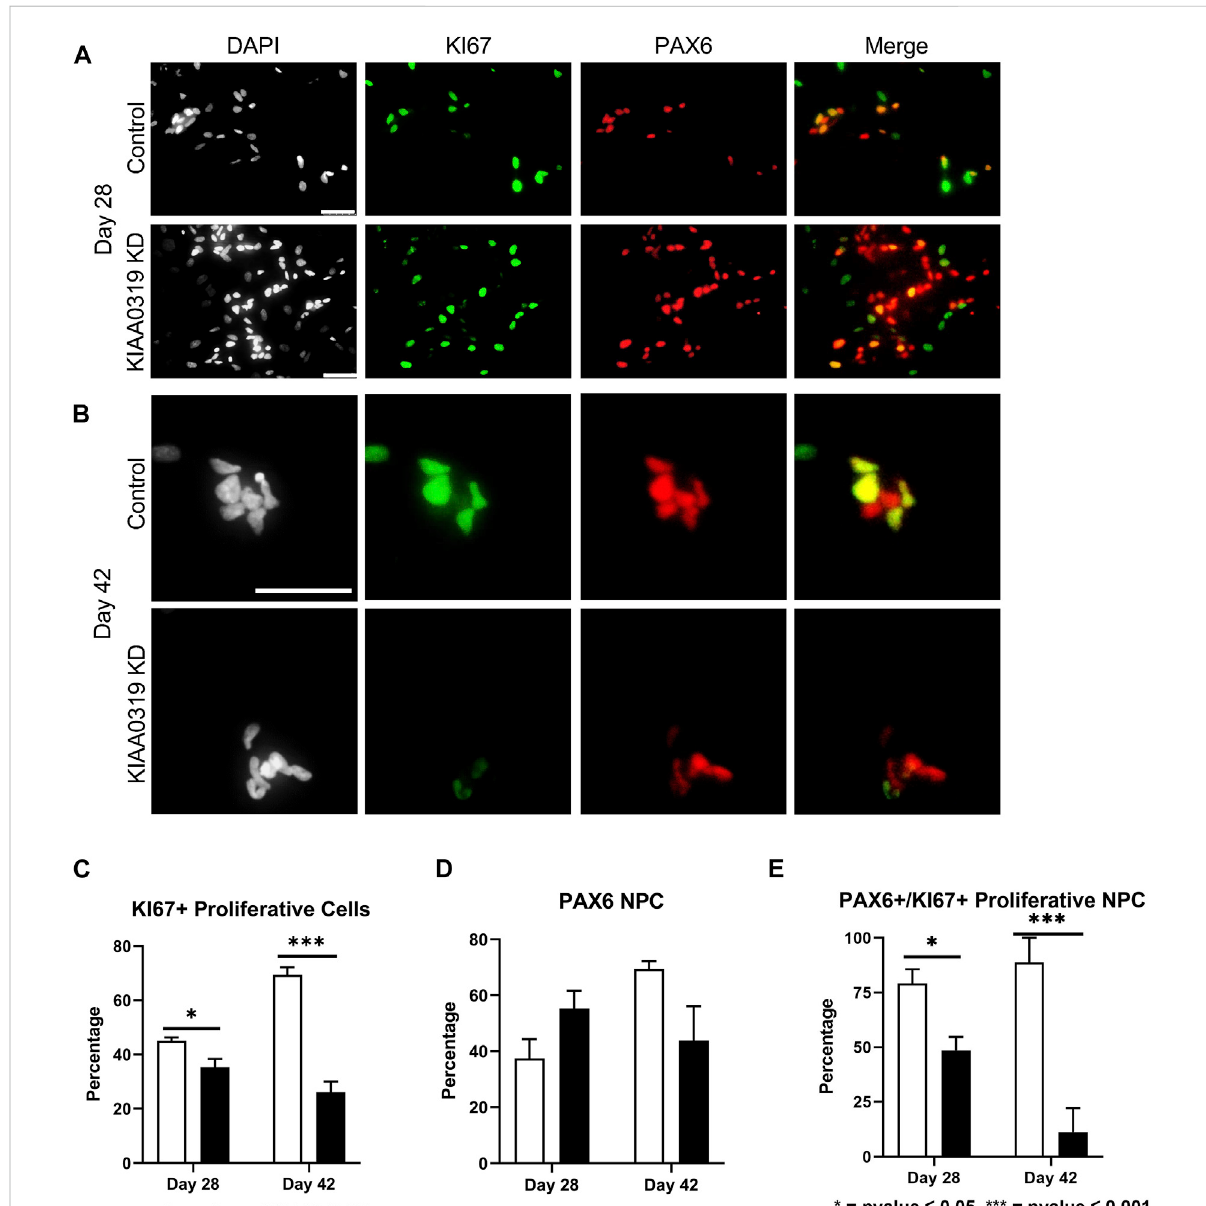
FIGURE 3 KIAA0319 KD decreases the percentage of proliferating neuronal progenitor cells. (A – B) Immunostaining of KIAA0319 KD and control cells for KI67(green)andPAX6(red)inDapi(gray)onday28 (A) andday42 (B) ofneuronaldifferentiation.Scalebar:50 µm.PercentageofKI67+cells (C) and PAX6+ population (D) among DAPI + cells at day 28 and day 42. Percentage of PAX6+ cells among KI67 + population at day 28 and day 42 (E) .